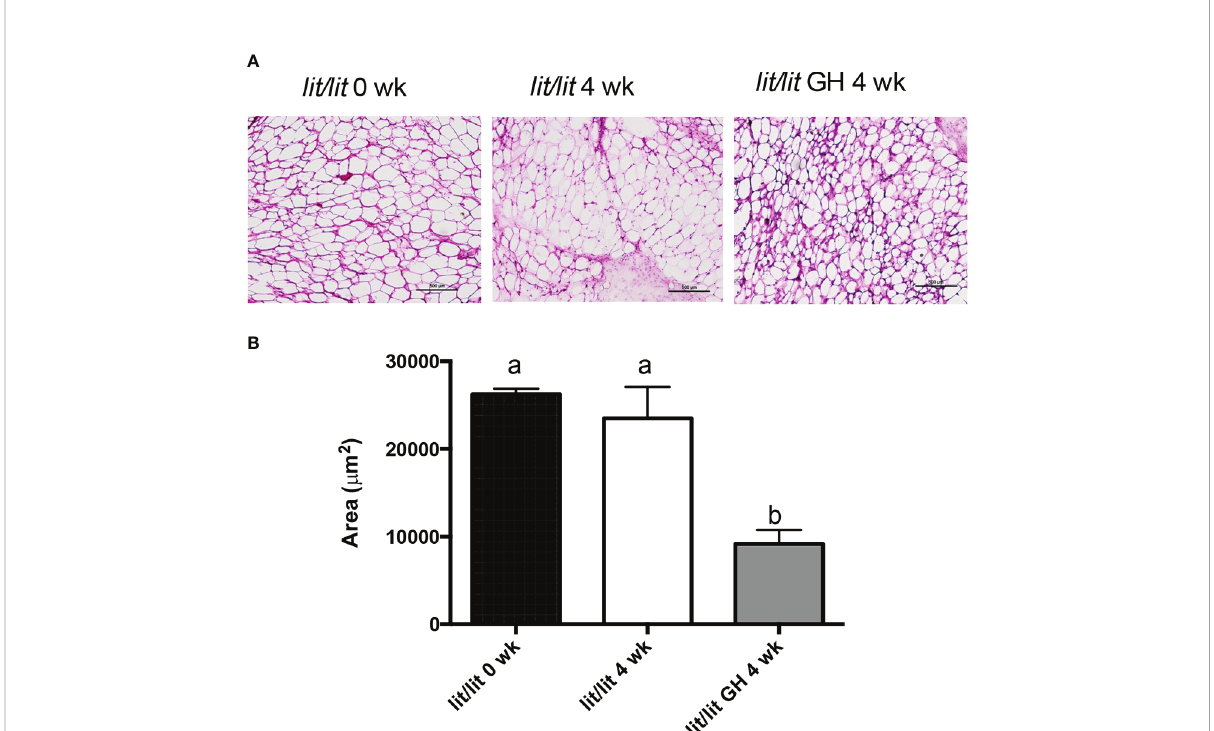
FIGURE 4 Adipocyte size of lit/lit mice before and after GH injection. Inguinal subcutaneous fat pads from 17-week-old lit/lit mice, 21-week-old lit/lit mice injected with GH for 4 weeks, and 21-week-old lit/lit mice injected with control for 4 weeks, indicated as lit/lit 0 wk, lit/lit GH 4 wk, and lit/lit 4 wk, respectively, in the graphs, were sectioned and stained with hematoxylin and eosin. (A) Representative photos of adipose tissue sections. (B) Average area of adipocytes. Data are expressed as mean ± SEM (n = 4 mice). Means labeled with different letters are statistically different ( P < 0.05).